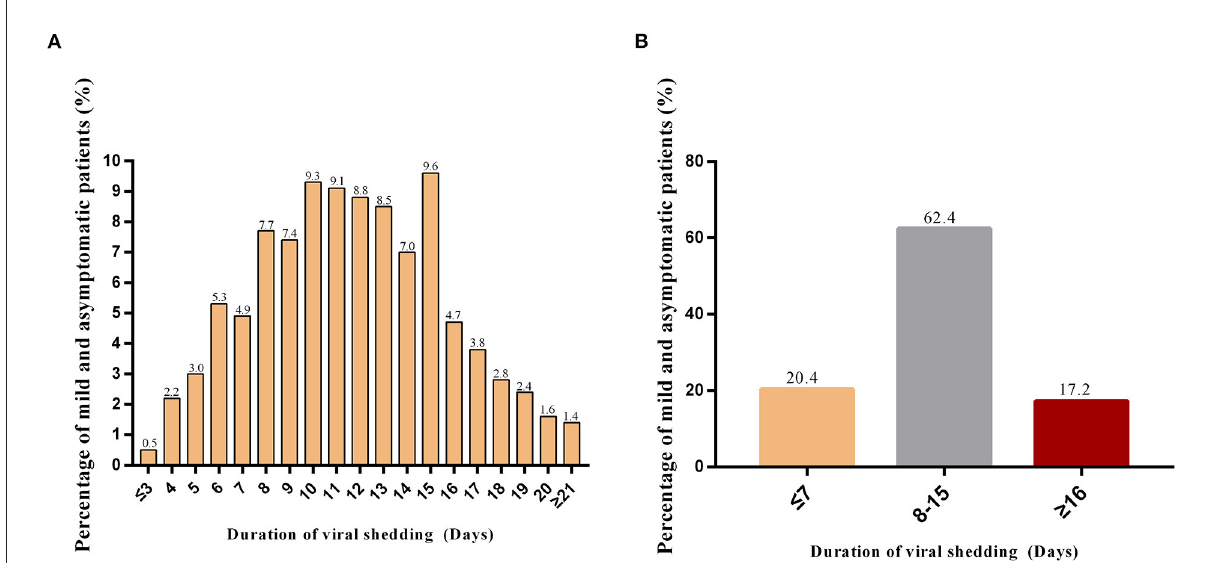
FIGURE1 Distribution of viral shedding time* for asymptomatic and mildly symptomatic Omicron-infected patients. (A) Distribution of viral shedding times; (B) The proportion of patients in the three groups with different viral shedding times. *The duration of viral shedding was defined as the first day of a positive nucleic acid test to the date of the first negative test of consecutive negative results. Participants received an oropharyngeal swab for SARS-CoV-2 RT-PCR test once daily during hospitalization, and were considered virus cleared when two consecutive SARS-CoV-2 RT-PCR tests were negative for nucleic acid [cycle threshold > 35 for both nucleocapsid protein (N) gene and open reading frame (ORF) 1ab gene], tested at intervals of at least